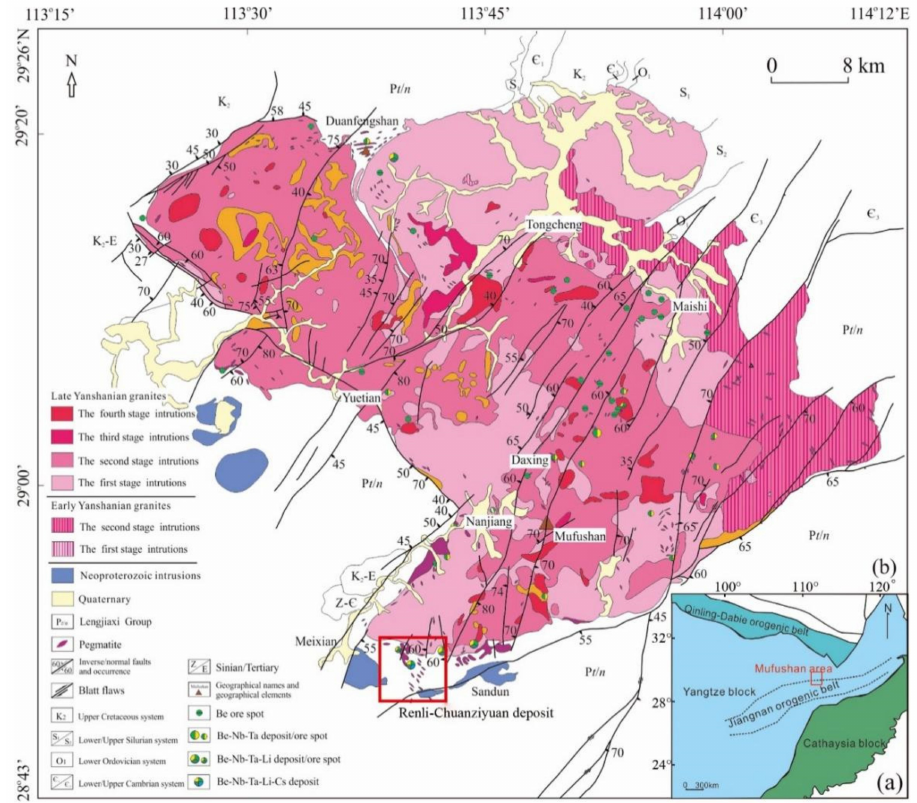
Figure 1. The location of the study area ( a ) and geological map ( b ) of the Mufushan area (modified after [19,27]).